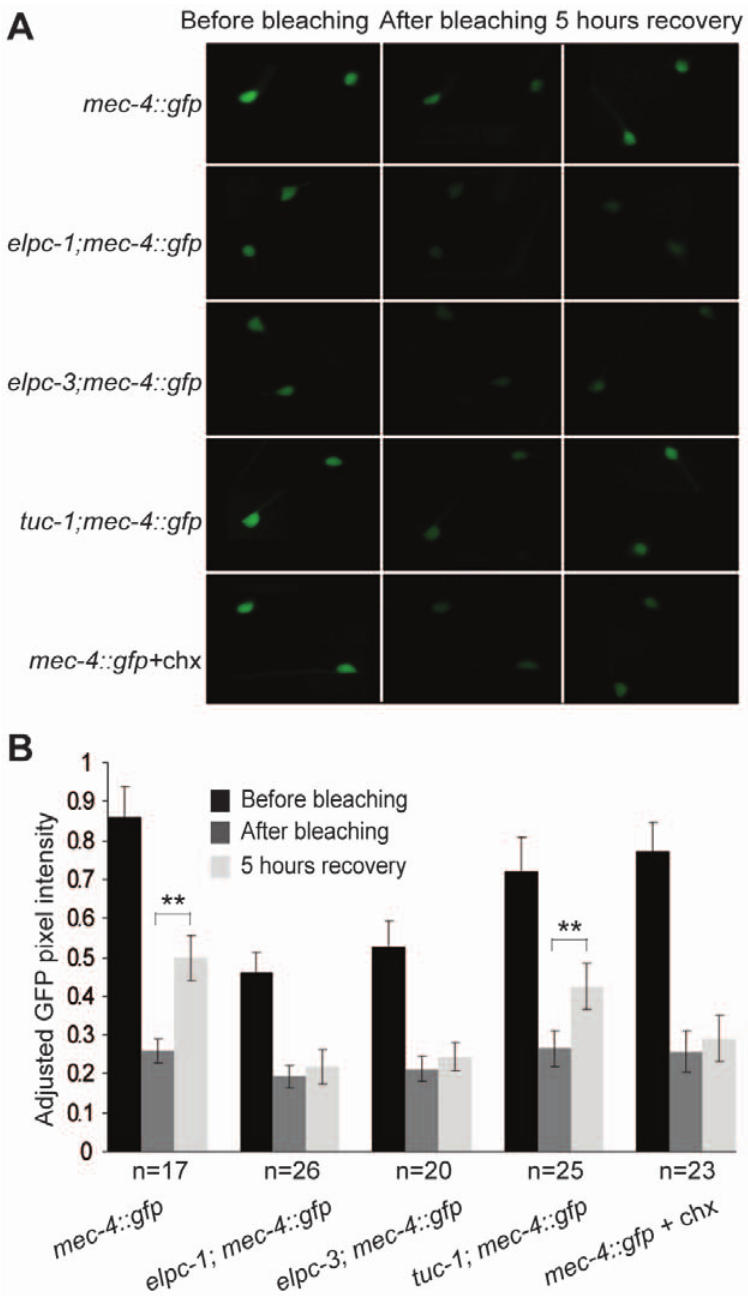
Figure 4. The elp-1(tm2149) and elpc-3(tm3120) mutants are defective in fluorescence recovery after photobleaching. (A) Images of mec-4::gfp reporter in wild type, elpc-1 , elpc-3 and tuc-1 backgrounds before photobleaching (left), after photobleaching (middle) and 5 hours recovery (right). The images at the bottom are of the mec-4::gfp reporter strain treated with the cycloheximide. (B) Quantification of GFP pixel intensities before photobleaching, after photobleaching and 5 hours recovery. The number of worms examined of each strain is given under the graph. Error bars represent standard deviations. Two asterisks indicate a significant fluorescence recovery after 5 hours incubation by student’s t test (**p , 0.001). (Figure S8). elpc-1 and elpc-3 mutant worms showed normal response to levamisole (Figure 6F), which activates the post-synaptic acetylcholine receptor [49], suggesting a defect in the pre-synaptic compartment. These results suggest that either less acetylcholine is produced in the neurons or less acetylcholine is released from the neurons in the elpc-1 and elpc-3 mutants.